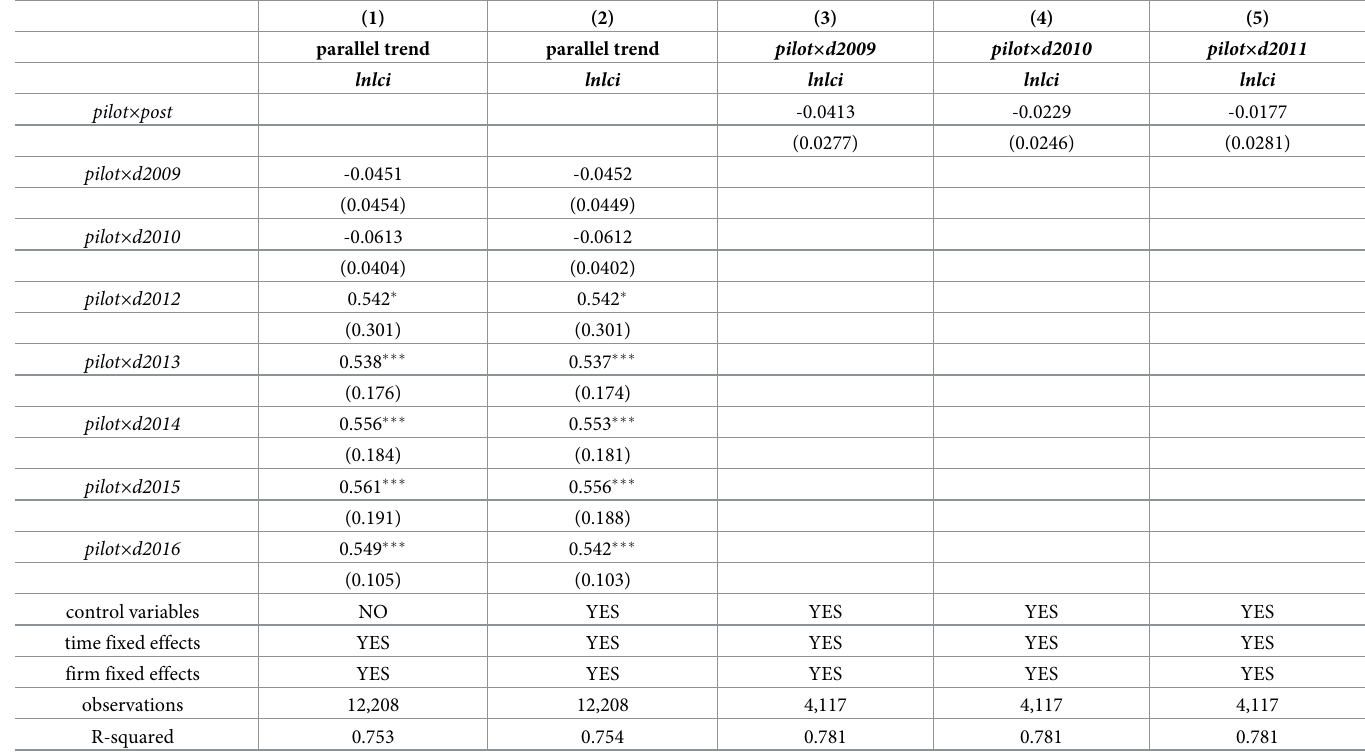
Table 3. Parallel trend test and placebo test.